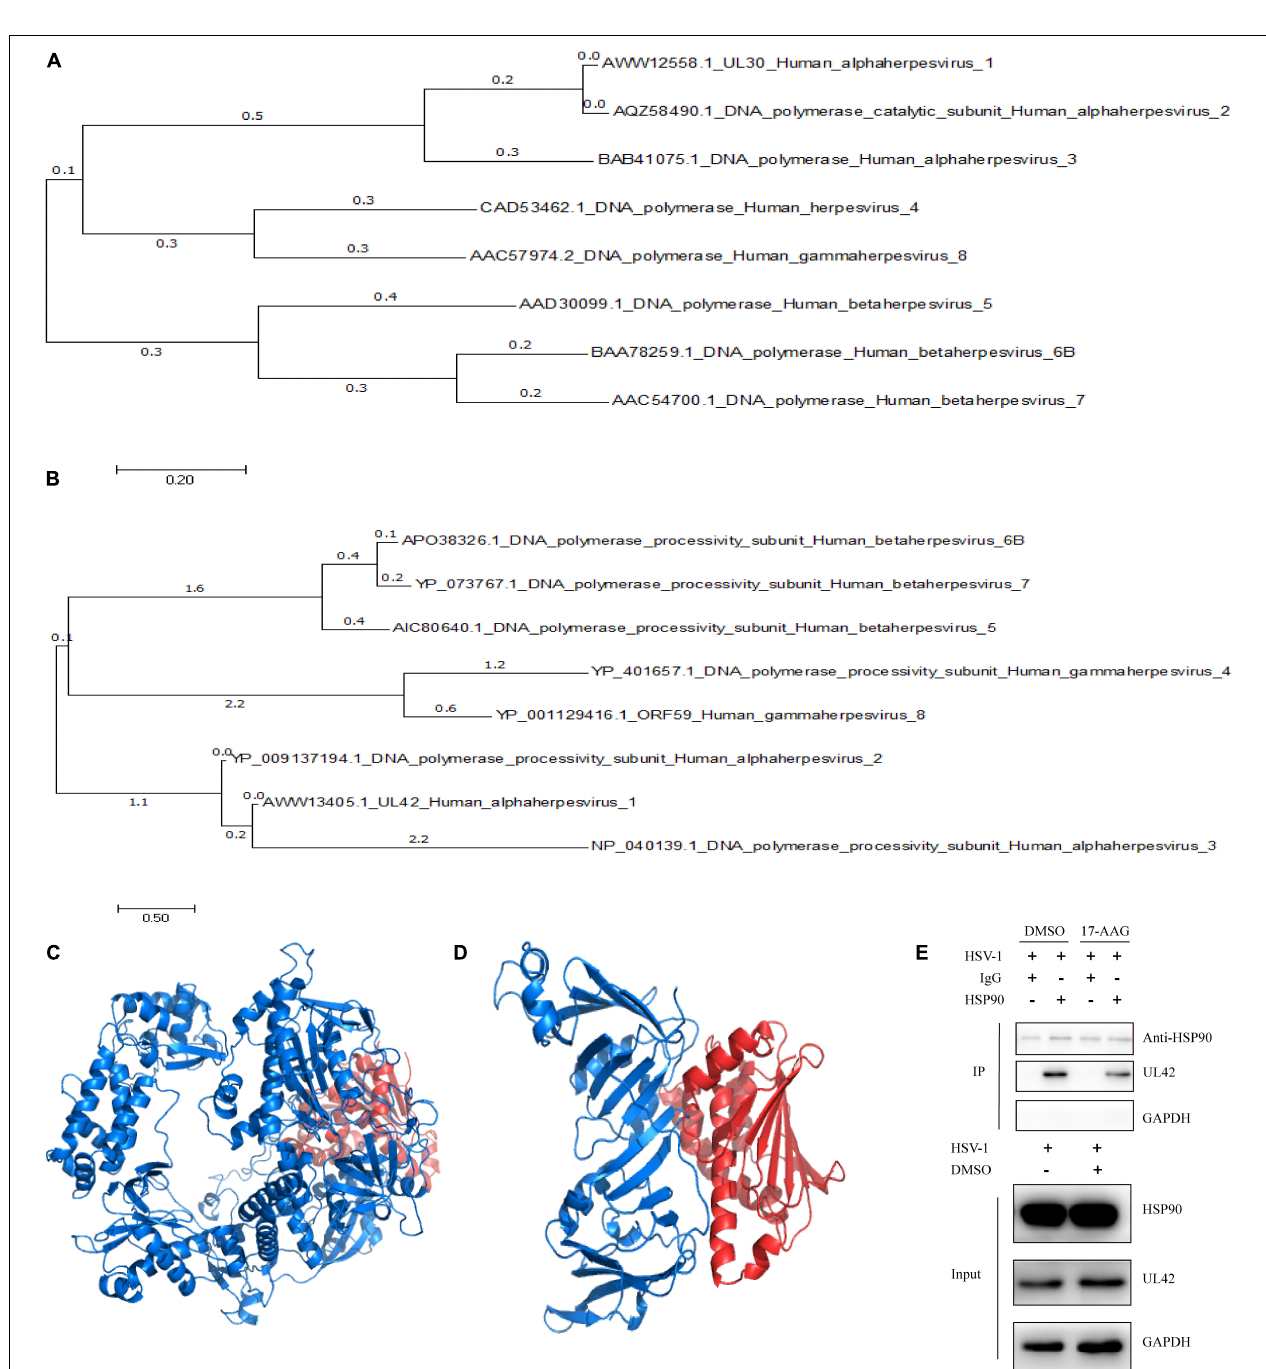
FIGURE 2 | Hsp90 inhibitor-induced the dissociation between Hsp90 and UL42. (A) The phylogenetic tree analysis between HSV-1 UL30 and other Herpesviridae virus DNA polymerase catalytic subunits. (B) The phylogenetic tree analysis between HSV-1 UL42 and other Herpesviridae viral DNA polymerase processivity factors. (C) The cartoon schematic from protein docking stimulation between UL30 and Hsp90. (D) The cartoon schematic from protein docking stimulation between UL42 and Hsp90. (E) HFF cells were infected with HSV-1 (MOI = 20) and treated with 6.25 µ M 17-AAG at 4 hpi. Moreover, the co-immunoprecipitation was manipulated at 12